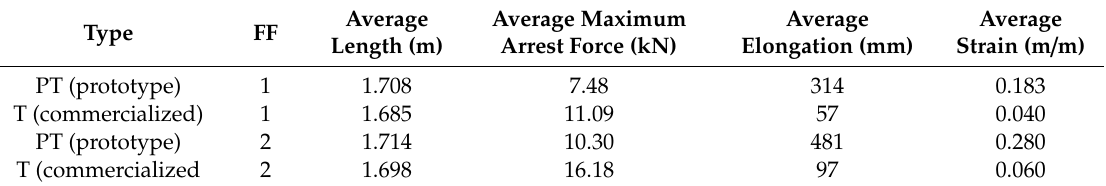
Table 7. Average results of lanyards